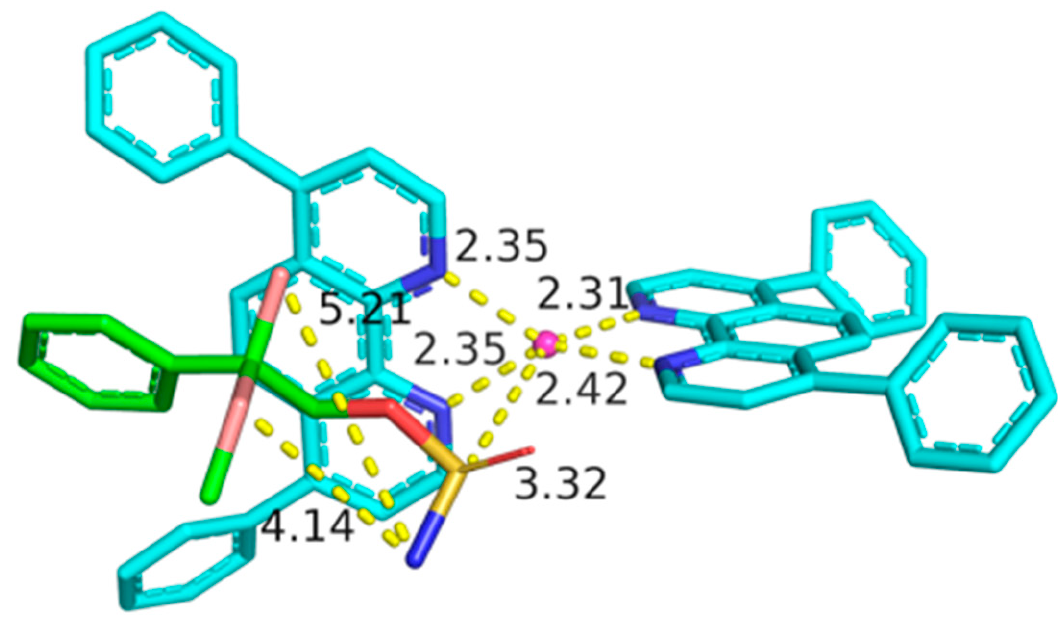
Figure 5. Reactant structure of the catalytic agent and molecule.